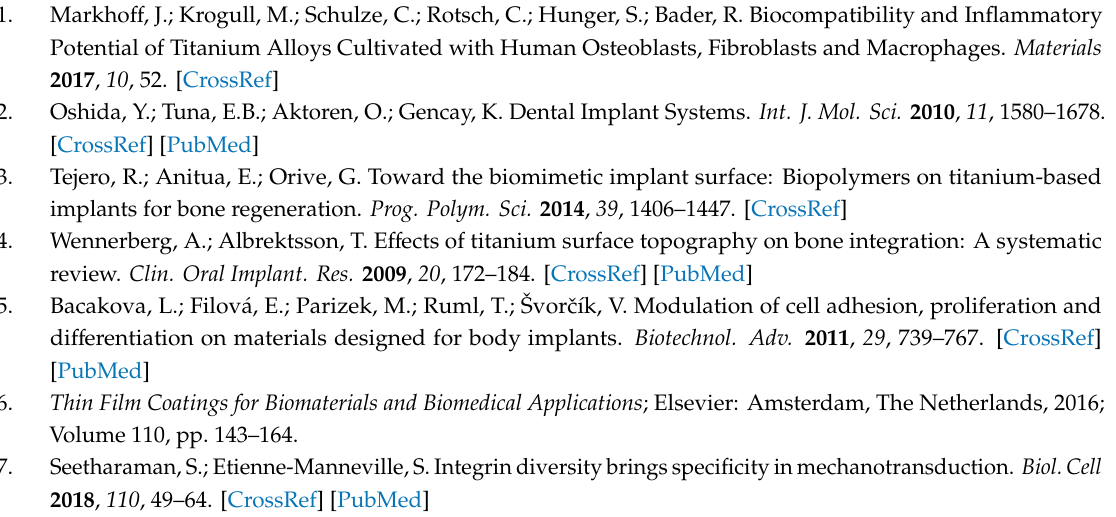
Figure S3: Proof of ROS generation, Figure S4: Source code of the Wnt model in ML-Rules, Figure S5: ICAT expression and localization, Figure S6: Frizzled expression, Table S1: Overview of genes, Table S2: Parameter values of the Wnt